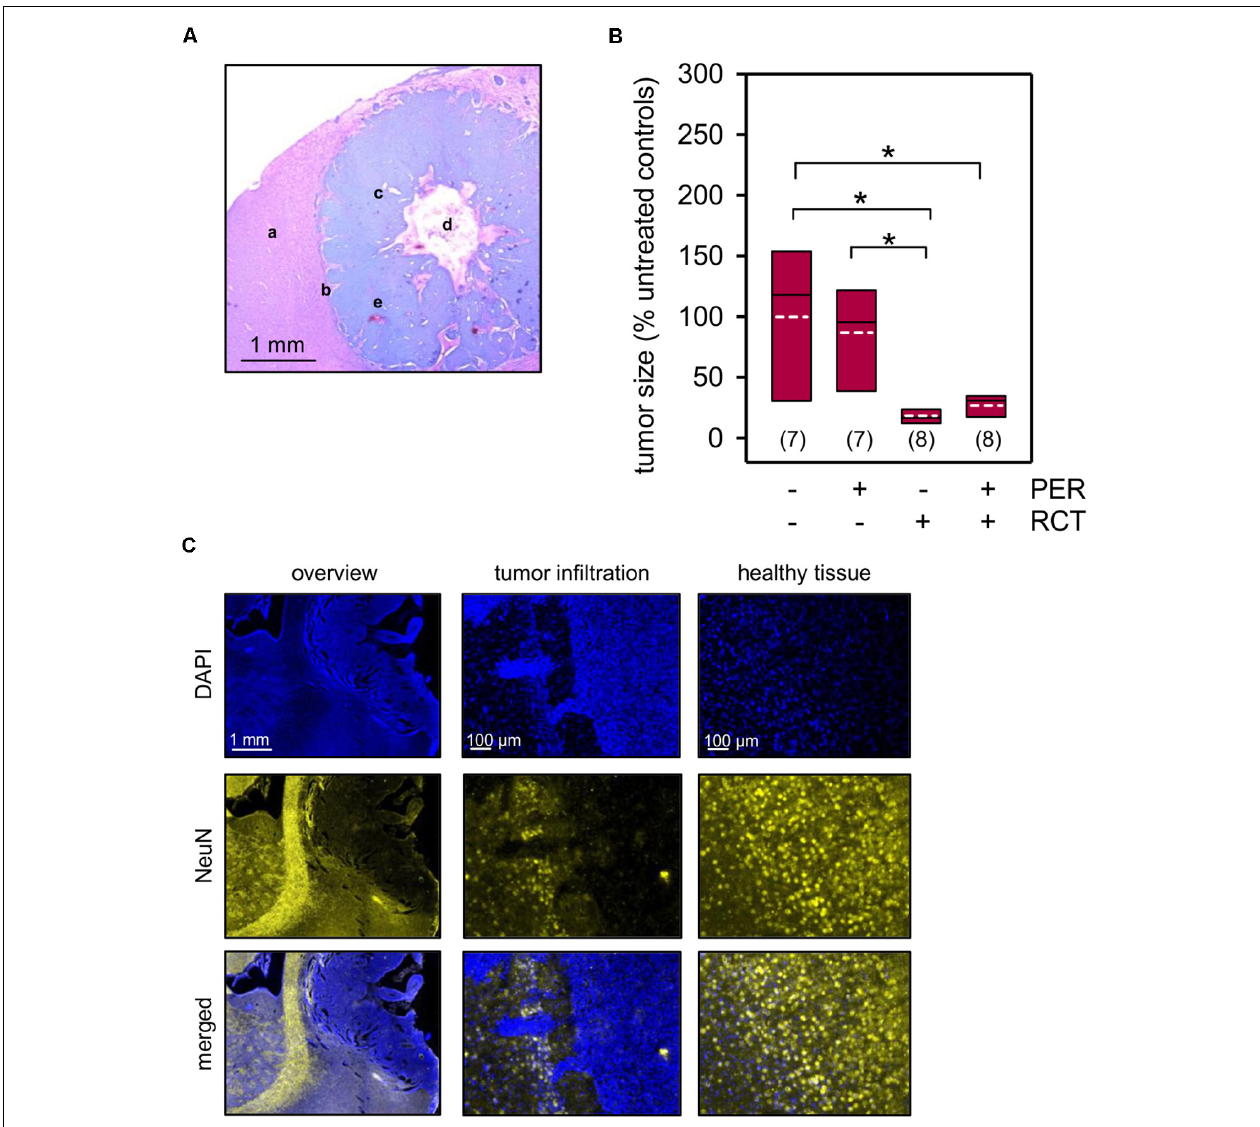
FIGURE 3 | Tumor size quantification. Animals with orthotopically-growing F98 glioma were sacrificed after 2 weeks and brains were prepared for further histological and morphological analysis. (A) Hematoxylin and eosin staining confirms the presence of F98 glioma. The sample picture shows healthy brain tissue (a), tumor infiltration (b), glioma cells (c), central necrosis (d), and microvascular hyperplasia (e). (B,C) The tumor volume was quantified in a three-dimensionally manner by NeuN expression (yellow) of the healthy brain tissue, whereas F98 glioma presented only little or no expression of the marker protein. Nuclei were counterstained with DAPI (blue); white dotted line represents arithmetic mean, black solid line represents median; n = number of animals per group; * p < 0.05 [Kruskal–Wallis test followed by post hoc analysis (Dunn’s